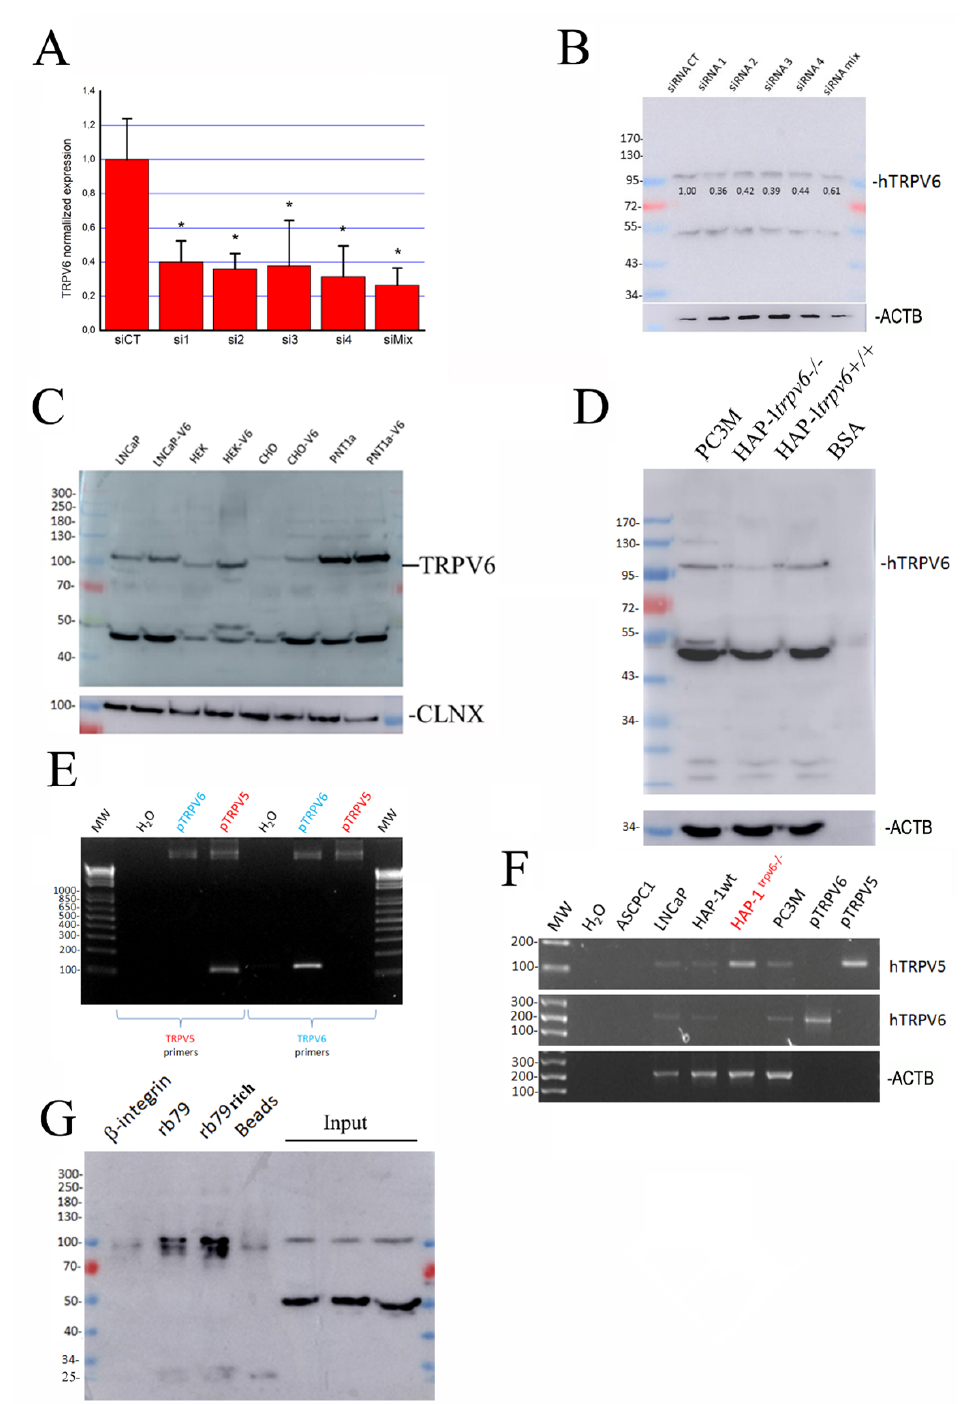
Figure 3. rb79 validation using knockdown, overexpression, and knockout models. ( A ), Quantitative real-time PCR of the TRPV6 channel in the LNCaP cells transfected either with the 40 µ M control siRNA (luciferase) or with the 40 nM siRNAs 1–4 against the TRPV6 channel or their mixture as compared to HPRT gene expression (see Table 1 for primers); n = 3, * p < 0.05. ( B ), A corresponding immunoblotting of the protein lysates from the siRNA-treated LNCaP cells under the same condi- tions as in ( A ), and the quantification of the bands as compared to ACTB. ( C ), transfection of the TRPV6 channel using the vEF1ap-5 (cid:48) UTR-TRPV6_CMVp-mCherry vector in LNCaP, HEK, CHO, and PNT1A cell lines and the corresponding immunoblotting. ( D ), TRPV6 protein expression in PC-3M, HAP-1 trpv6 − / − , and HAP-1 trpv6+/+ cell models versus BSA protein revealed using rb79, as compared